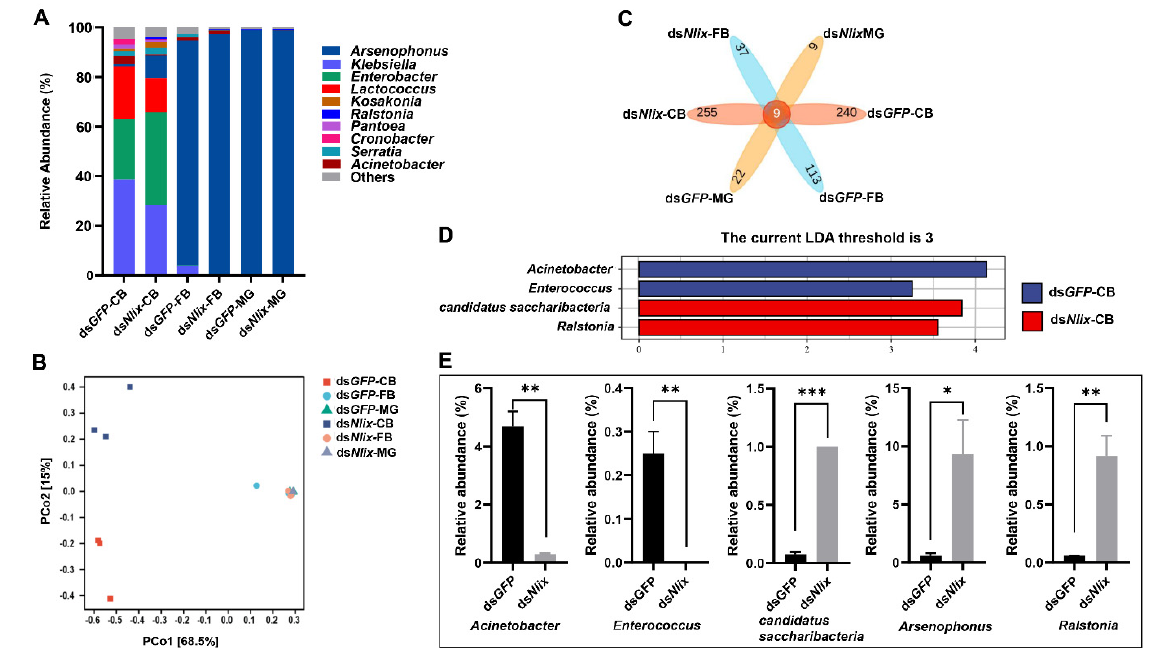
Figure 7. Microbial structural composition between ds GFP -treated group and ds Nlix -treated group: ( A ) Relative abundances of bacteria at the genus level in CB, FB, and MG of BPH in the ds Nlix -treated and control groups. The 10 species with the highest relative abundances were displayed, and the relative abundances of the remaining species were combined and grouped into Others; ( B ) Comparison of bacterial communities in samples treated with dsRNA via Bray–Curtis principal coordinate analysis; ( C ) Venn diagrams of the bacterial ASVs in CB, FB, and MG of BPH treated with dsRNA. The overlapping areas between blocks indicated the ASVs common to the corresponding groups, and the values in each block indicated the number of ASVs contained in the block; ( D ) LEfSe analysis based on ASV abundance in BC between ds GFP - and ds Nlix -treated samples; ( E ) Comparative analysis of abundance in the genera of Acinetobacter , Enterococcus , candidate saccharibacteria , Arsenophous , and Ralstonia under different treatments. *, **, and *** indicate significant differences between ds GFP treatment and ds Nlix treatment at p < 0.05, p < 0.01, and p < 0.001 levels, respectively. CB: copulatory bursa; FB: fat body; MG: midgut.